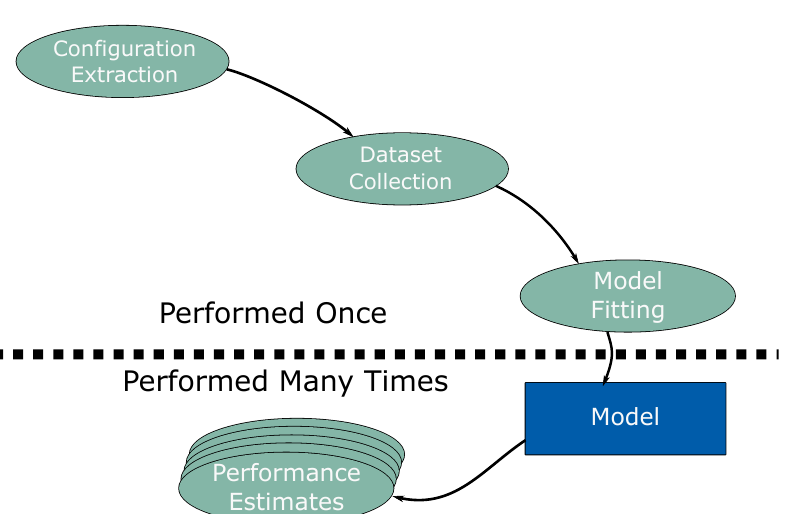
Figure 1. A visualization of the entire flow. The configuration extraction, data collection, and model training steps are only completed once, while the trained model will perform many